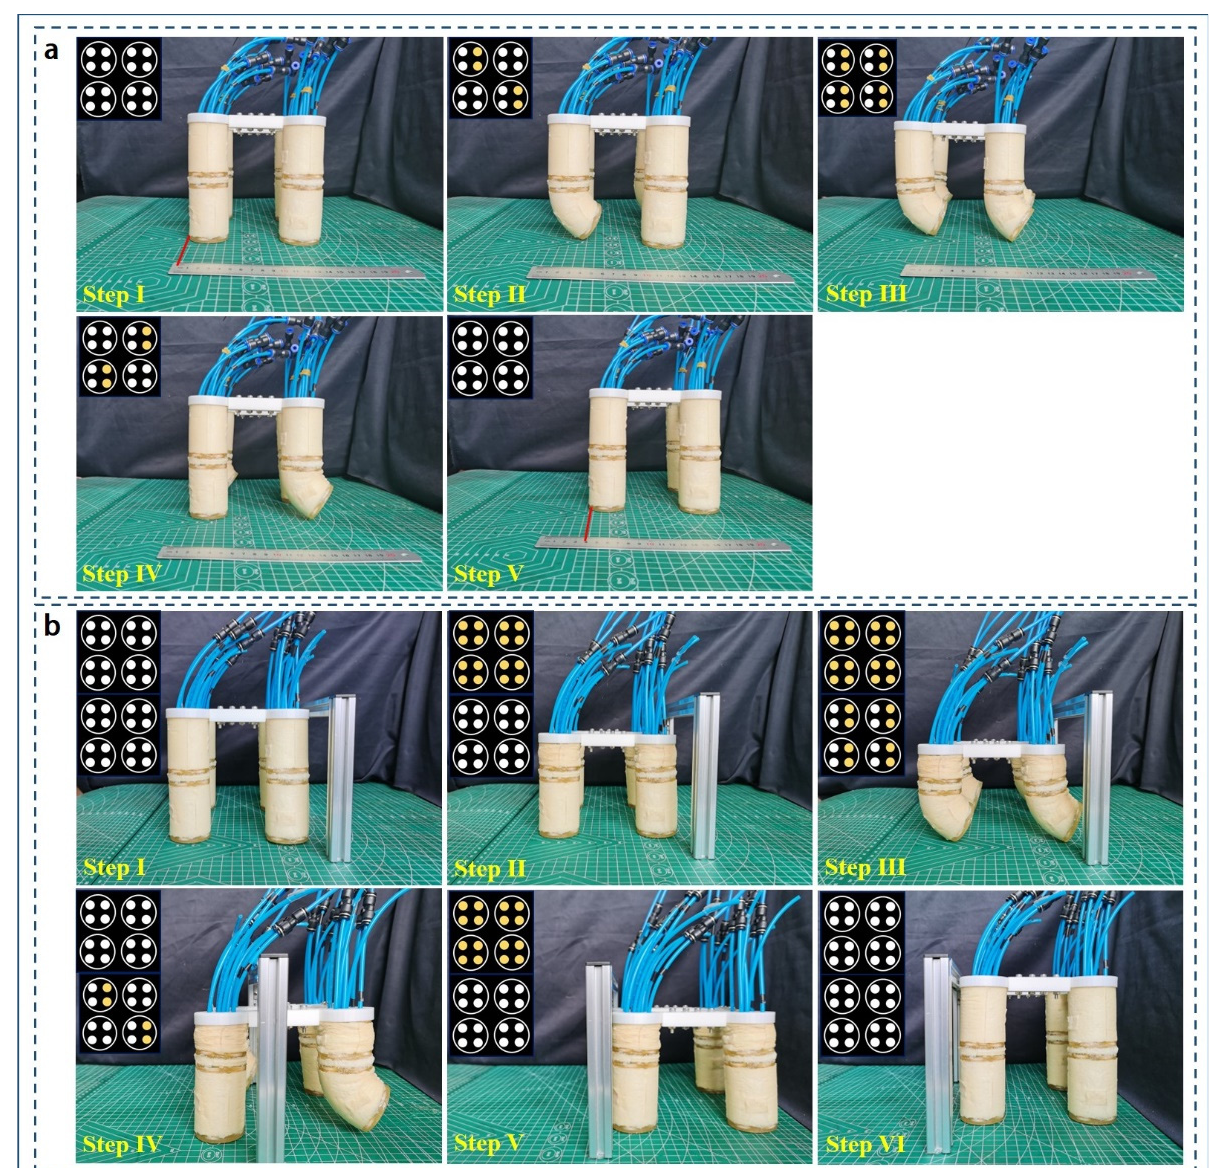
Figure 12. Quadruped-like soft robot: ( a ) Walking process and the corresponding pumping sequence; ( b ) obstacle avoidance process and the corresponding pumping sequence (yellow: pumping, white: no air pressure).